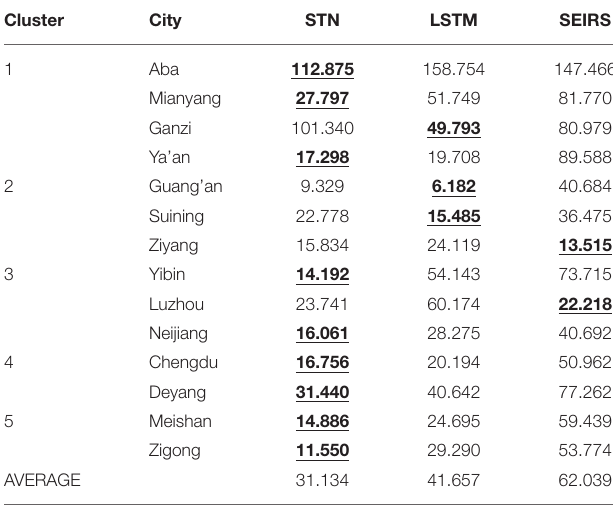
TABLE 2 | The comparison of the forecasting mean absolute percentage error (MAPE) of the three methods.